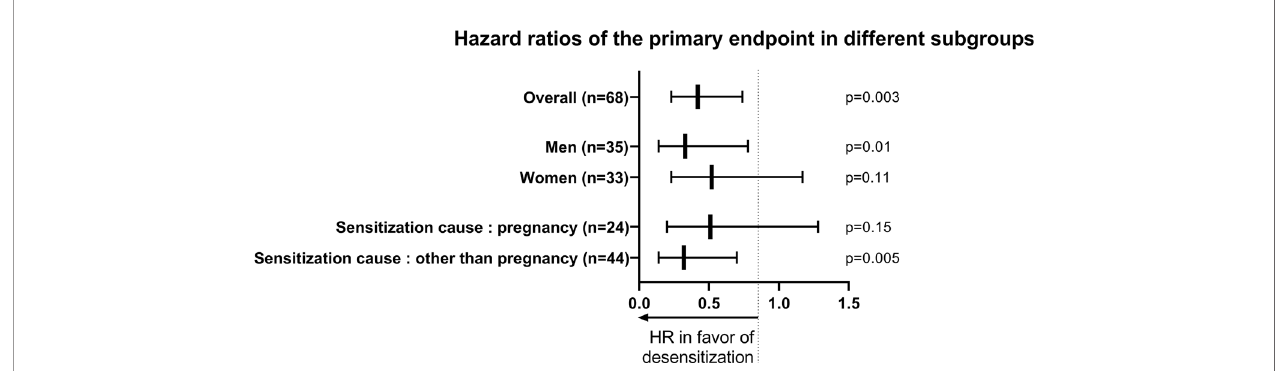
FIGURE 4 | Forest plot comparing the ef fi cacy of desensitization in different subgroups, on the incidence of the main composite endpoint (death and